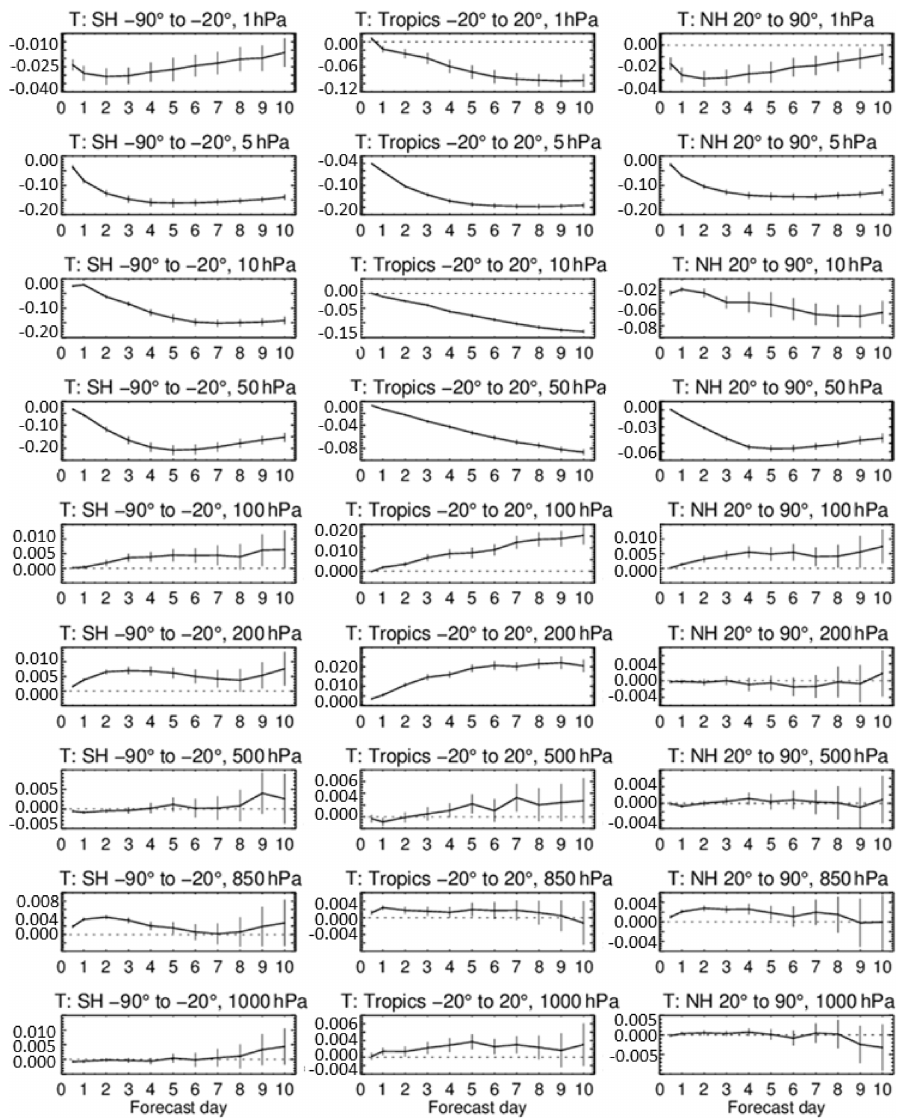
Figure 9. Normalised differences in root mean square error (DRMSE) in the forecast temperature field (K) with the new and default ozone schemes, as a function of lead time. The forecast model runs cover a 1-year period, with 10d forecasts from August 2012 to July 2013. The figure shows three latitudinal bands, 90–20 ◦ S (left column), 20 ◦ S–20 ◦ N (centre column) and 20–90 ◦ N (right column), for different pressure levels as labelled for each row, from 1.0 to